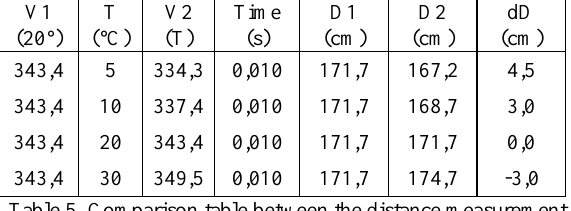
Table 5. Comparison table between the distance measurement at the standard temperature of 20 ° C (columns V1 and D1), and the distance measure at the actual temperature (columns V2 (t) and D2). The column dD shows the difference between D1 (distance measured at the standard temperature) and D2 (distance measured at the actual temperature). Table 5 shows how the variation of the temperature influence on the measured values.